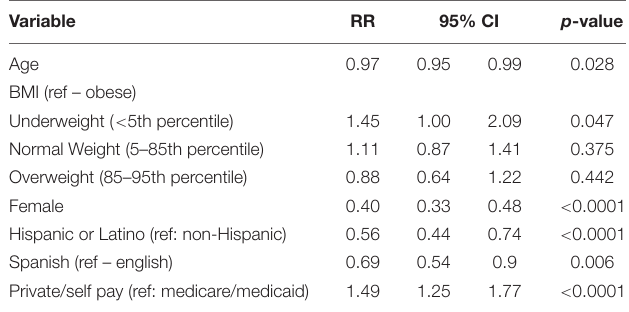
TABLE 2 | Association between ADHD status and variables of interest. TABLE 3 | Univariate logistic regression (relative risk) of ADHD